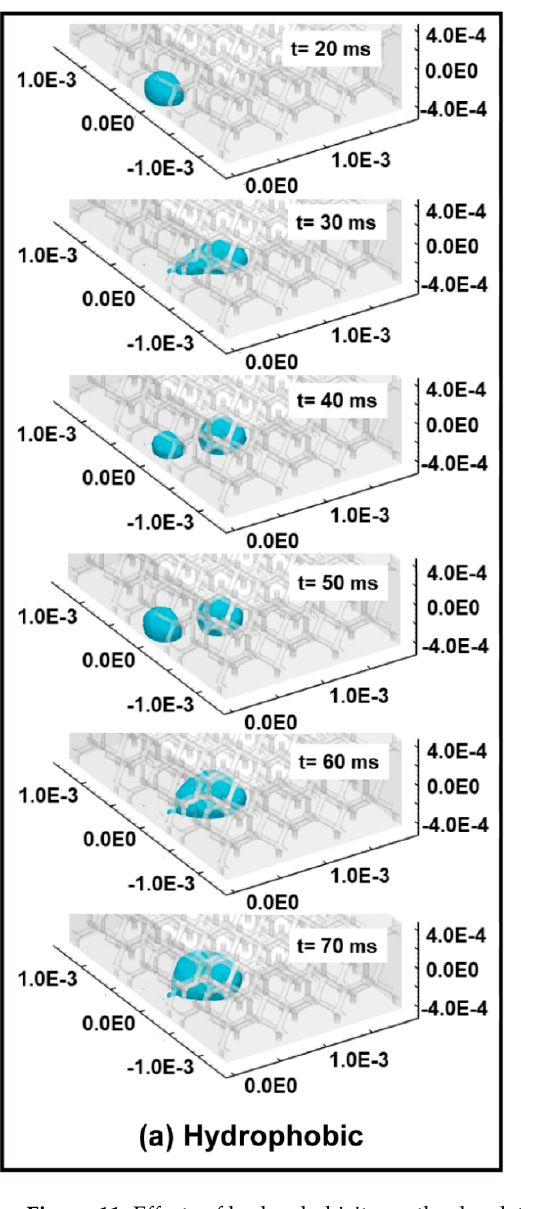
Figure 11. Effects of hydrophobicity on the droplet movement for airflow rate 3 ms − 1. and ( b )